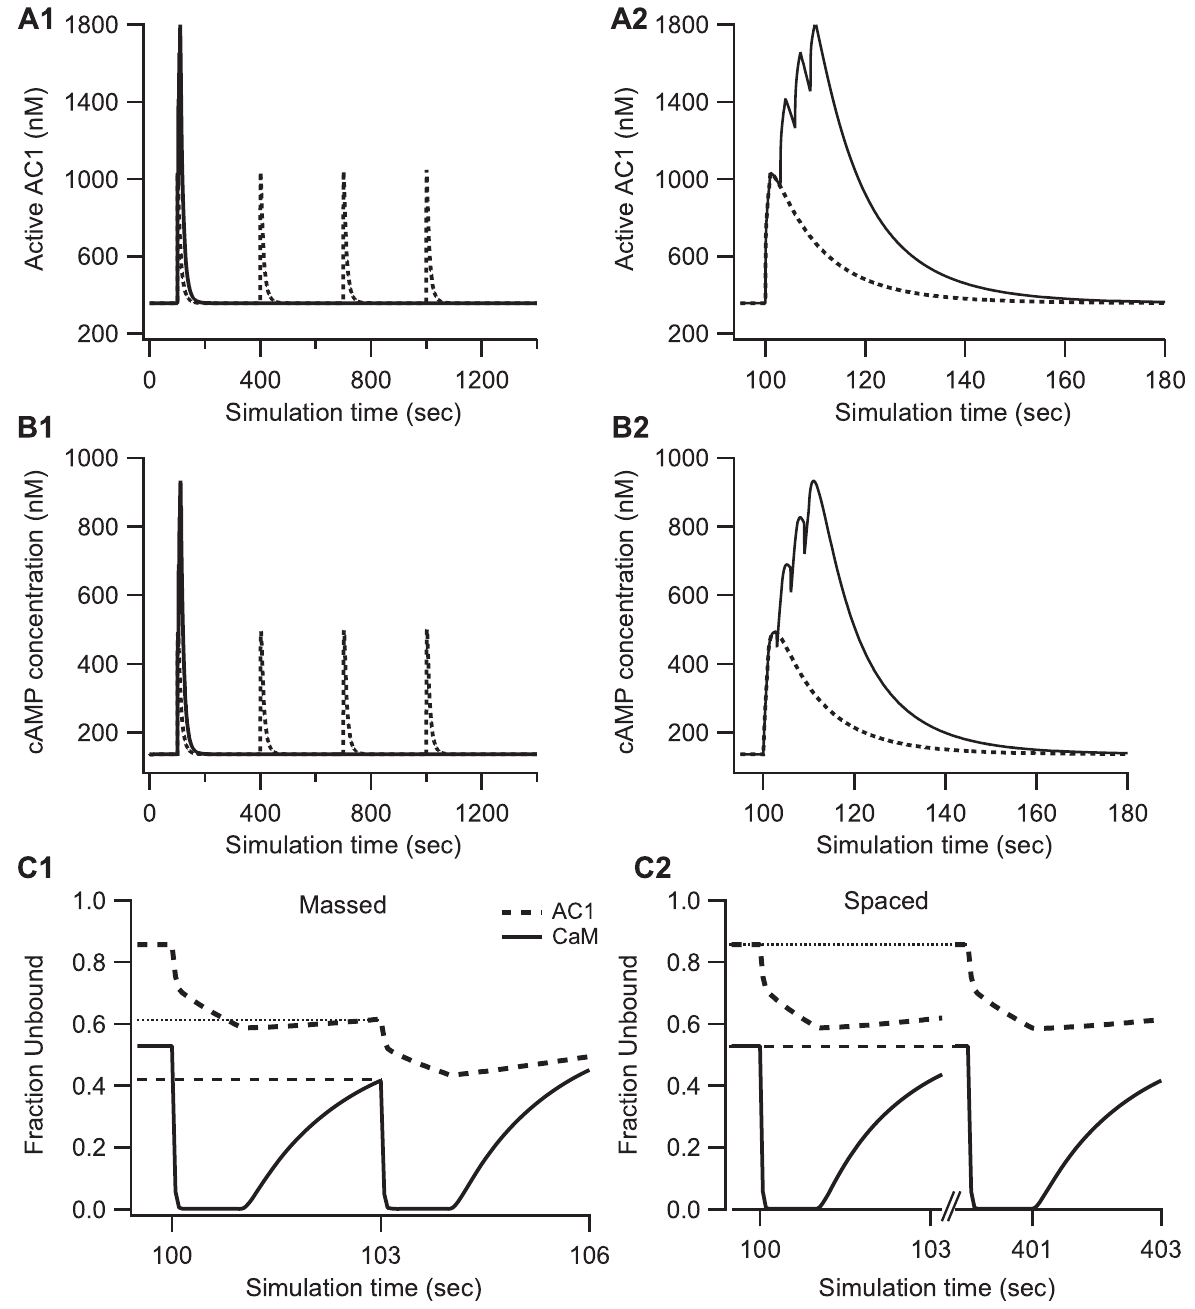
Figure 5. Mechanism underlying sensitivity of PKA activation to different temporal patterns of stimulation. In both (A) and (B) the left column (A1, B1) shows 1400 sec of simulation time and the right column (A2, B2) shows the first 180 sec to better show the four tetani of massed stimulation. (A) With massed trains, activation of adenylyl cyclase begins to saturate with the first train, leading to sublinear summation of adenylyl cyclase activity in response to subsequent trains; (B) cAMP concentration exhibits sub-linear summation with massed stimuli; thus less cAMP is produced with massed than with spaced trains. (C) Depletion of adenylyl cyclase and calmodulin contribute to the non-linear summation. Fractions of unbound adenylyl cyclase 1 and calmodulin are much lower for the second stimulus train for massed stimulation (C1), but not for spaced stimulation (C2). Dashed horizontal line allows comparison of unbound calmodulin between first and second train. Dotted horizontal line allows comparison of unbound adenylyl cyclase 1 between first and second